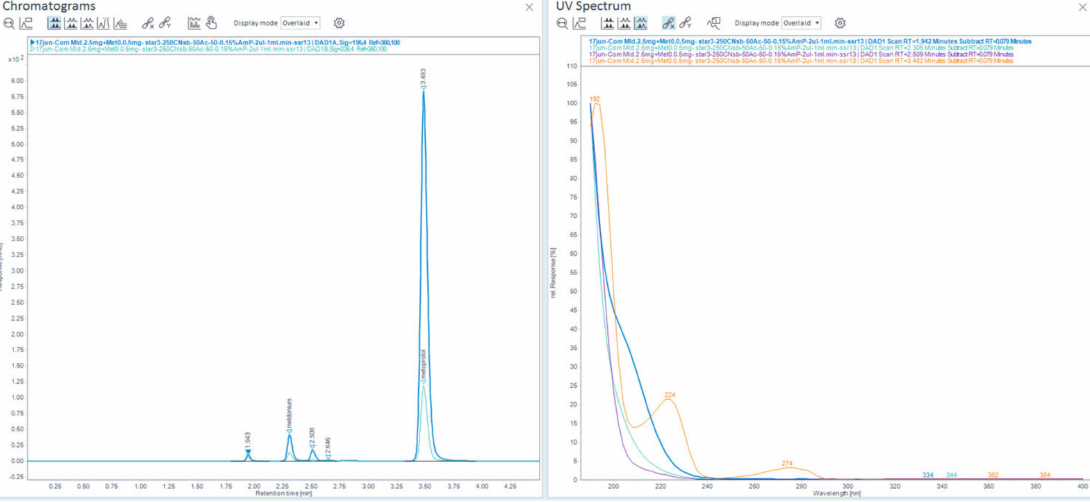
Figure 37. Chromatograms, obtained by usage mobile phase composed of 50% ACN and 50% 13 mM NH 4 H 2 PO 4 , the most effective separation was achieved in less than a 4 min run time. The second peak was meldonium on chromatogram, and the last highest peak was metoprolol, the third and fourth peaks were